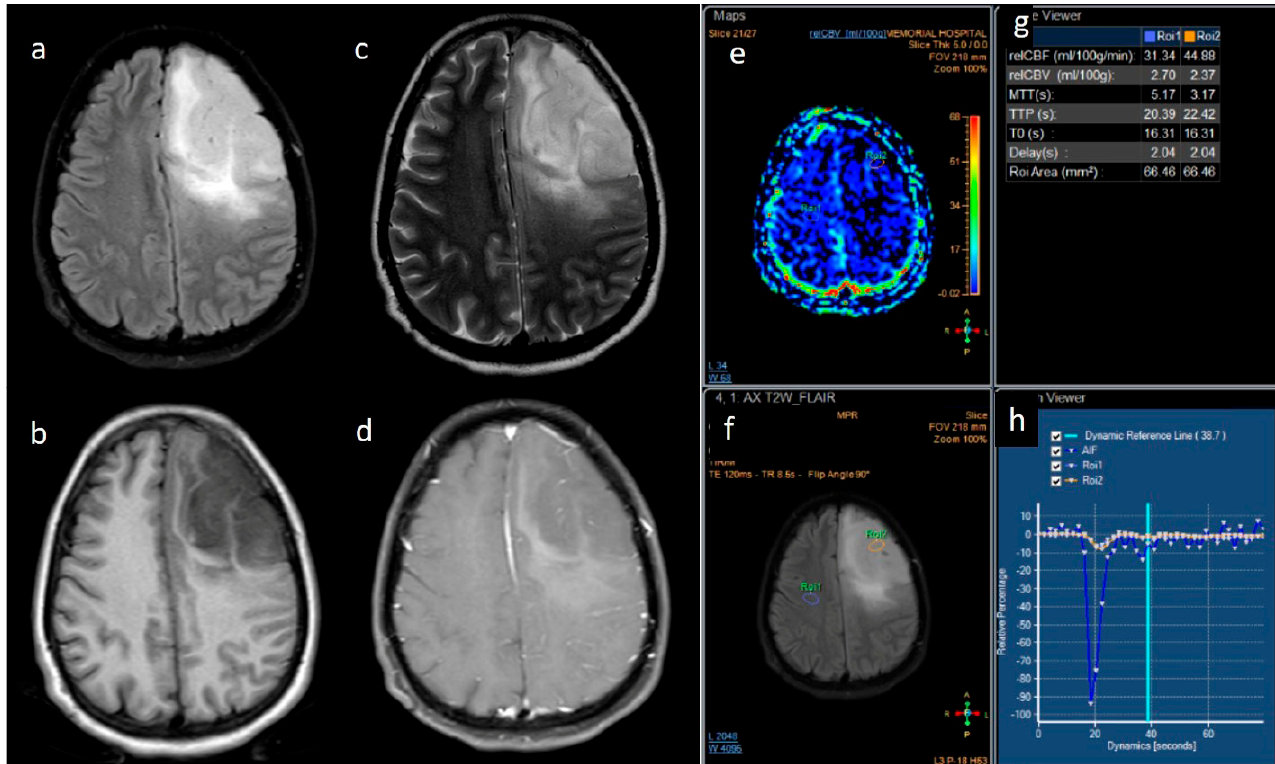
Figure 1. ( a – h ) FLAIR, T1, T2, post-contrast T1, perfusion color map, and graph representative of IDH-mutant grade 4 astrocytoma. Images a–d show a homogenous well-circumscribed mass without necrosis and edema less than the tumor volume. Images e–h are dynamic susceptibility contrast images showing hypoperfusion. Table 1. Patient demographic and tumor profiles, and their correlation with IDH